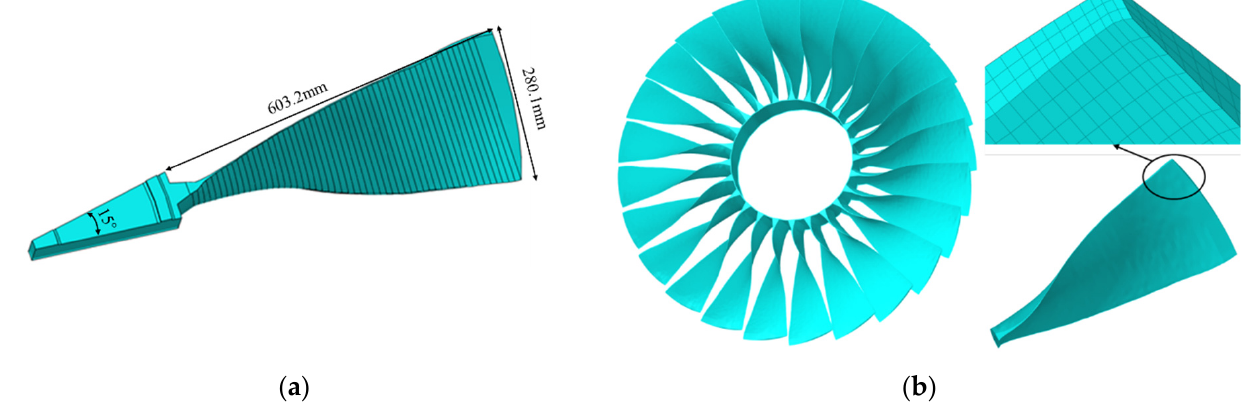
Figure 3. The aero-engine fan model used in simulations: ( a ) geometrical model; ( b ) finite element model.